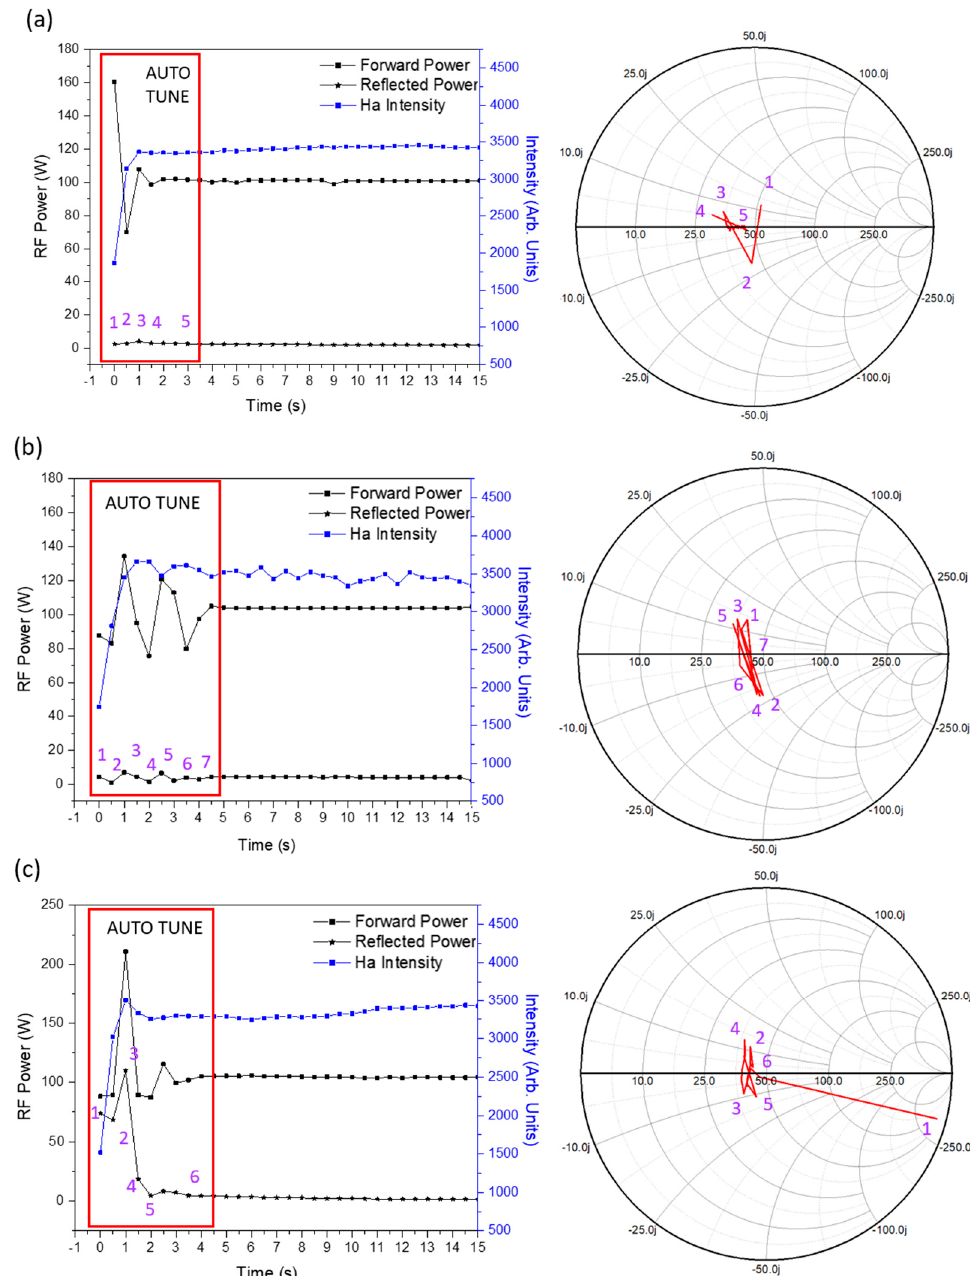
Figure 9. The repeatability of impedance tuning and related OES intensities are performed for three times ( a – c ) at R = 20.